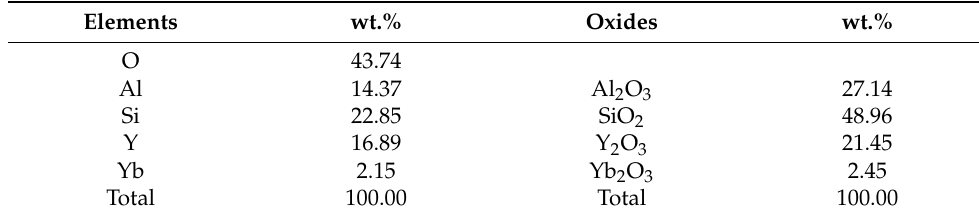
Table 1. Elemental concentrations of YCDSF.